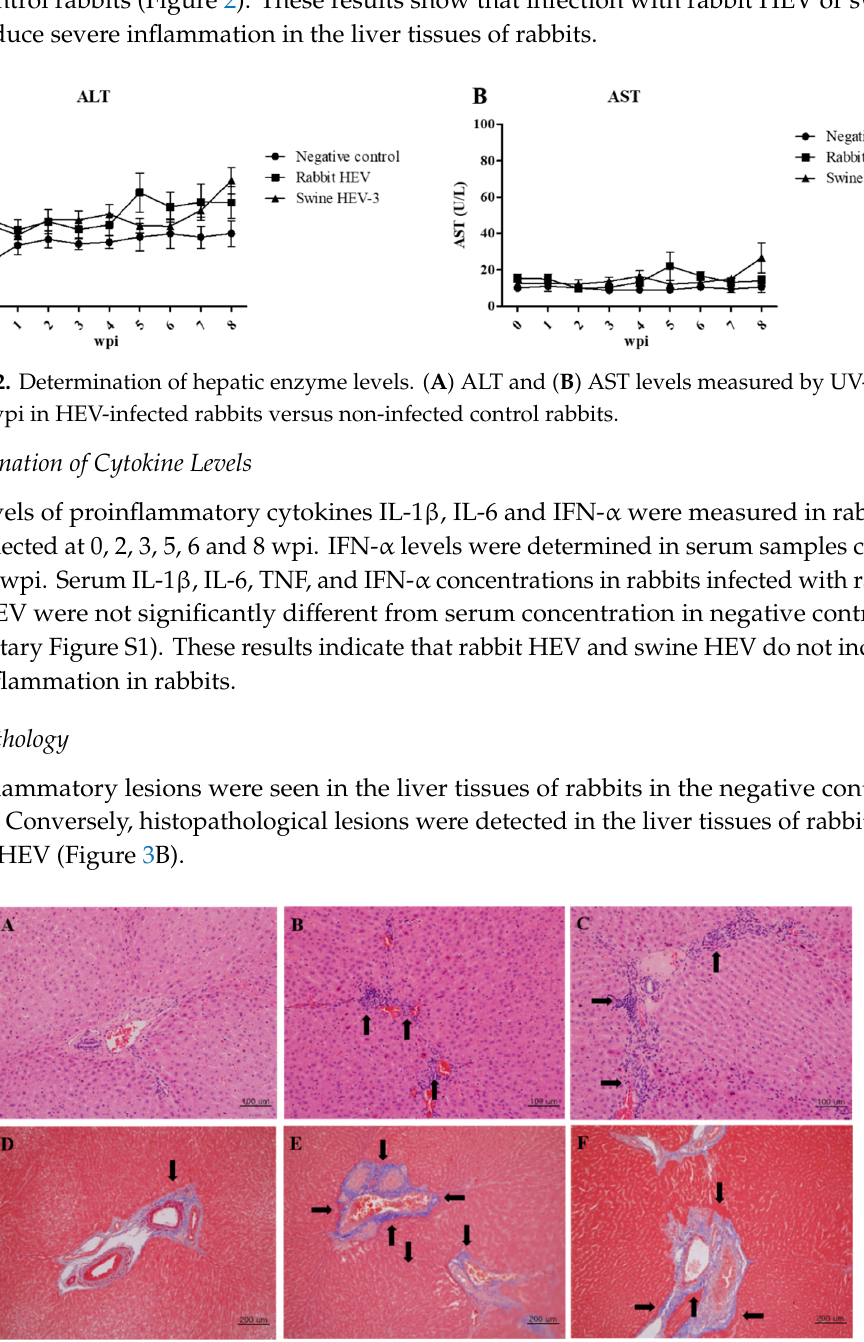
Figure 3. Detection of histopathological lesions in the liver tissues. Liver tissues collected at 8 wpi from ( A ) negative control, ( B ) rabbit HEV-infected, and ( C ) swine HEV-3-infected rabbits were stained using H&E. Liver tissues of ( D ) negative control, ( E ) rabbit HEV-infected, and ( F ) swine HEV-3-infected rabbits were stained using Masson’s trichrome staining method. Arrows indicate ( A – C ) inflammation and ( D – F ) fibrosis.